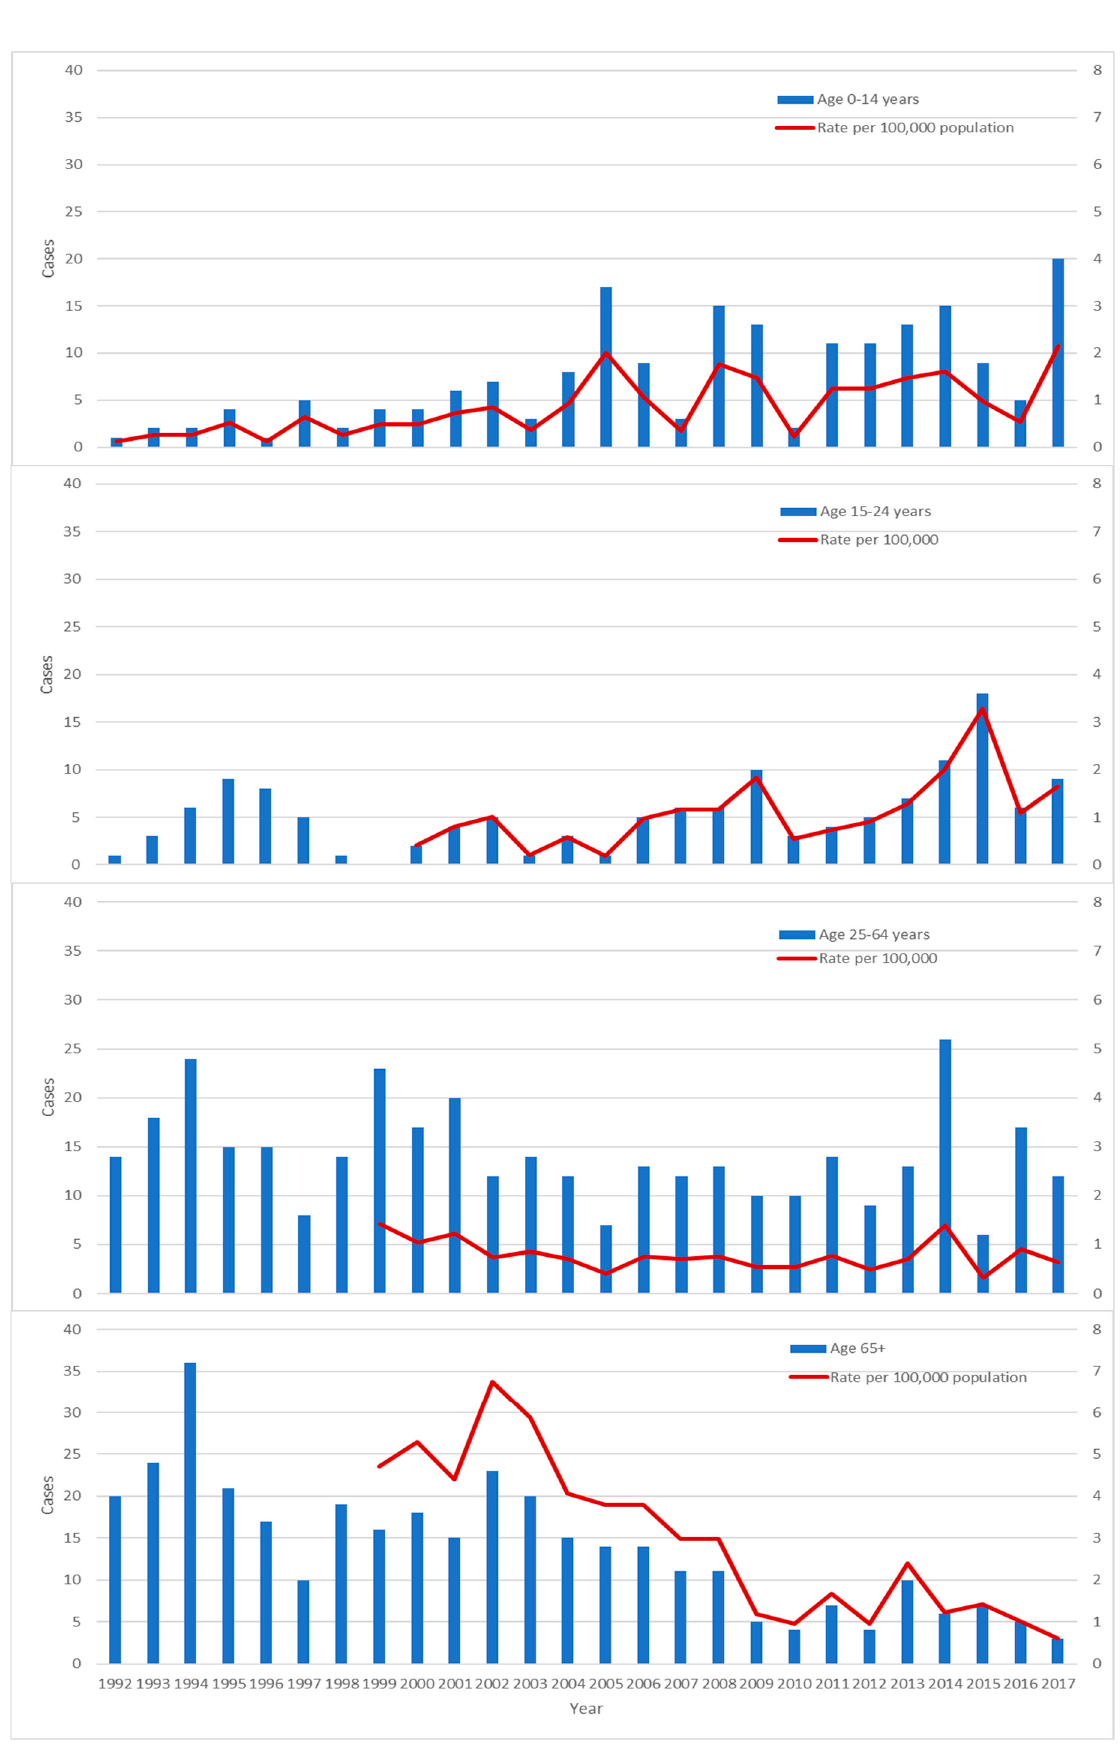
Figure 3. Number of cases per year and incidence per year by age group.